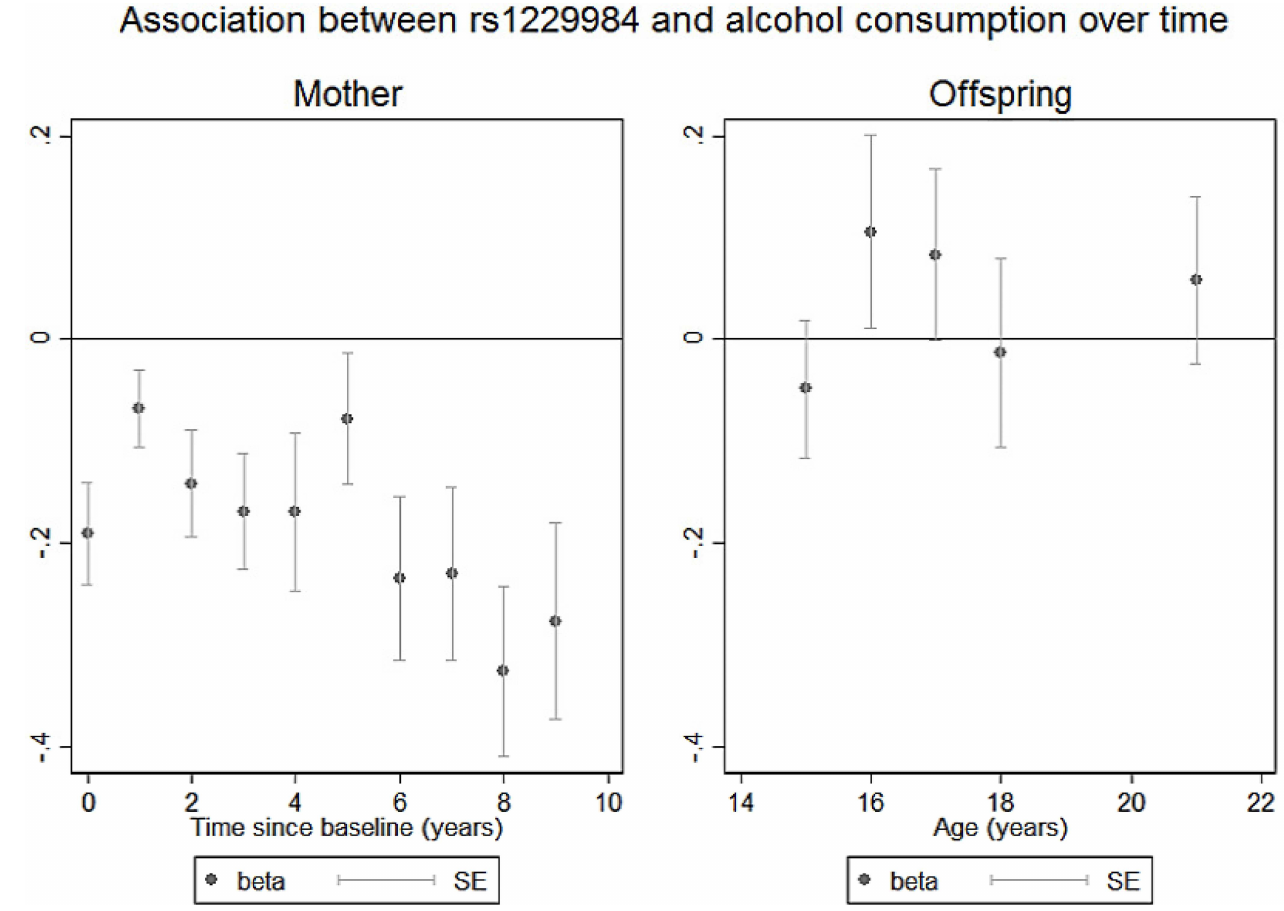
Fig 1. Association between rs1229984 and alcohol consumption over